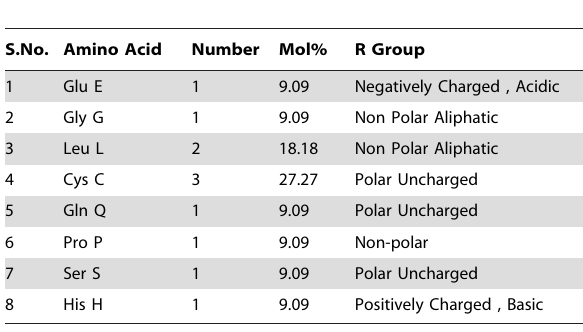
Table 1. Amino acid compositional analysis of Pi54 Zinc finger